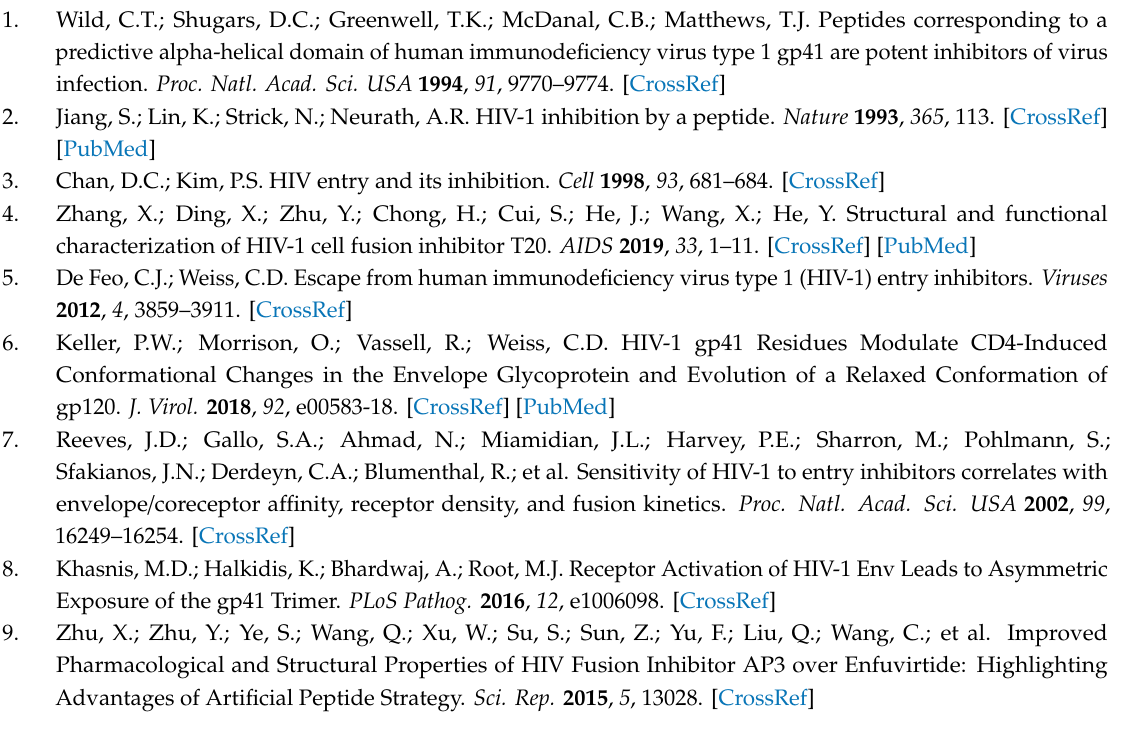
di ff erential selection for biological triplicates. Figure S2. The complete, mutation-level resistance profile across Env. Figure S3. TZM-bl inhibition assay performed with 10 µ g / mL DEAE-dextran instead of the 100 µ g / mL concentration used in Figure 3 and resistance profiling experiments. Figure S4. Comparing BG505 enfuvirtide resistance to BG505 (subtype A) mutational tolerance, LAI (subtype B) mutational tolerance, and natural sequence